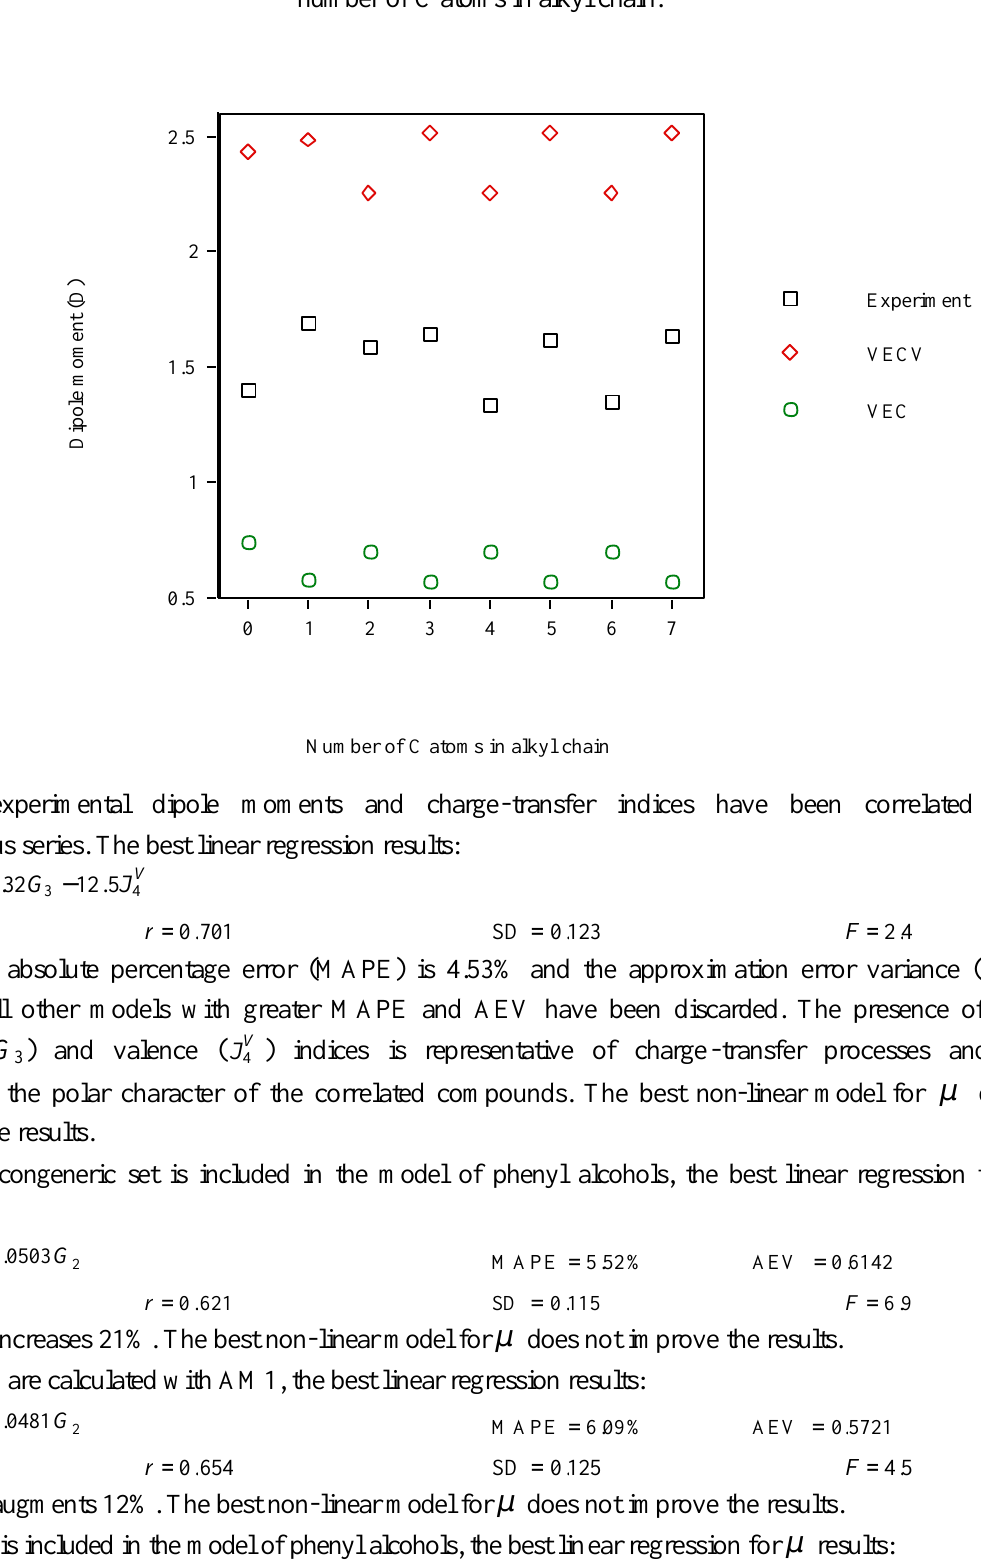
Figure 1. Dipole moment of homologous phenyl alcohols as a function of the number of C atoms in alkyl